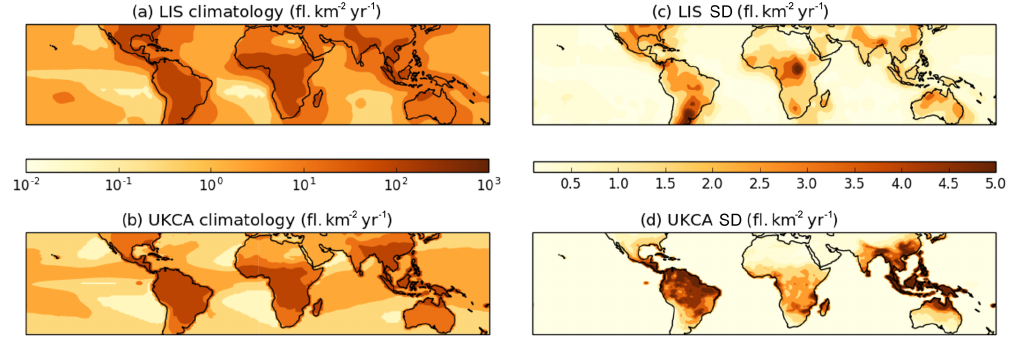
Figure 1. Tropical distribution of the LIS-observed (Lightning Imaging Sensor) climatological annual mean lightning flash density over the period 1999–2013 (a) in comparison with the modelled annual mean climatology from the period 2005–2014 (b) . The corresponding standard deviation of the observed and modelled climatologies are shown in panels (c) and (d) ,